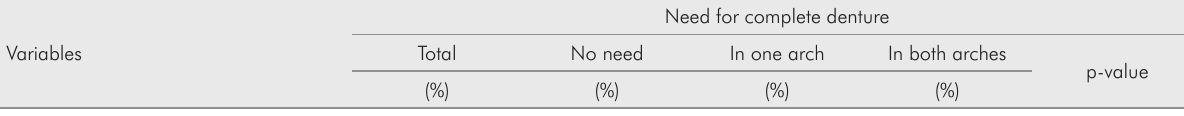
Table 1. Description of independent variables according to dependent variable (n =